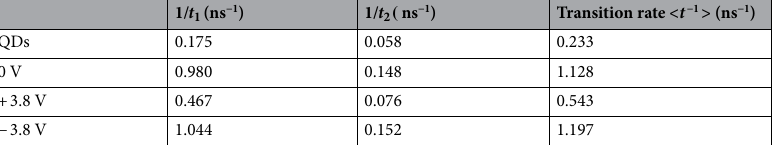
Table 2. Summary of the charge transition rate estimated from the decay time of the QDs on quartz and full devices with zero bias, light-emitting mode (+ 3.8 V) and light-detecting mode (− 3.8 V).